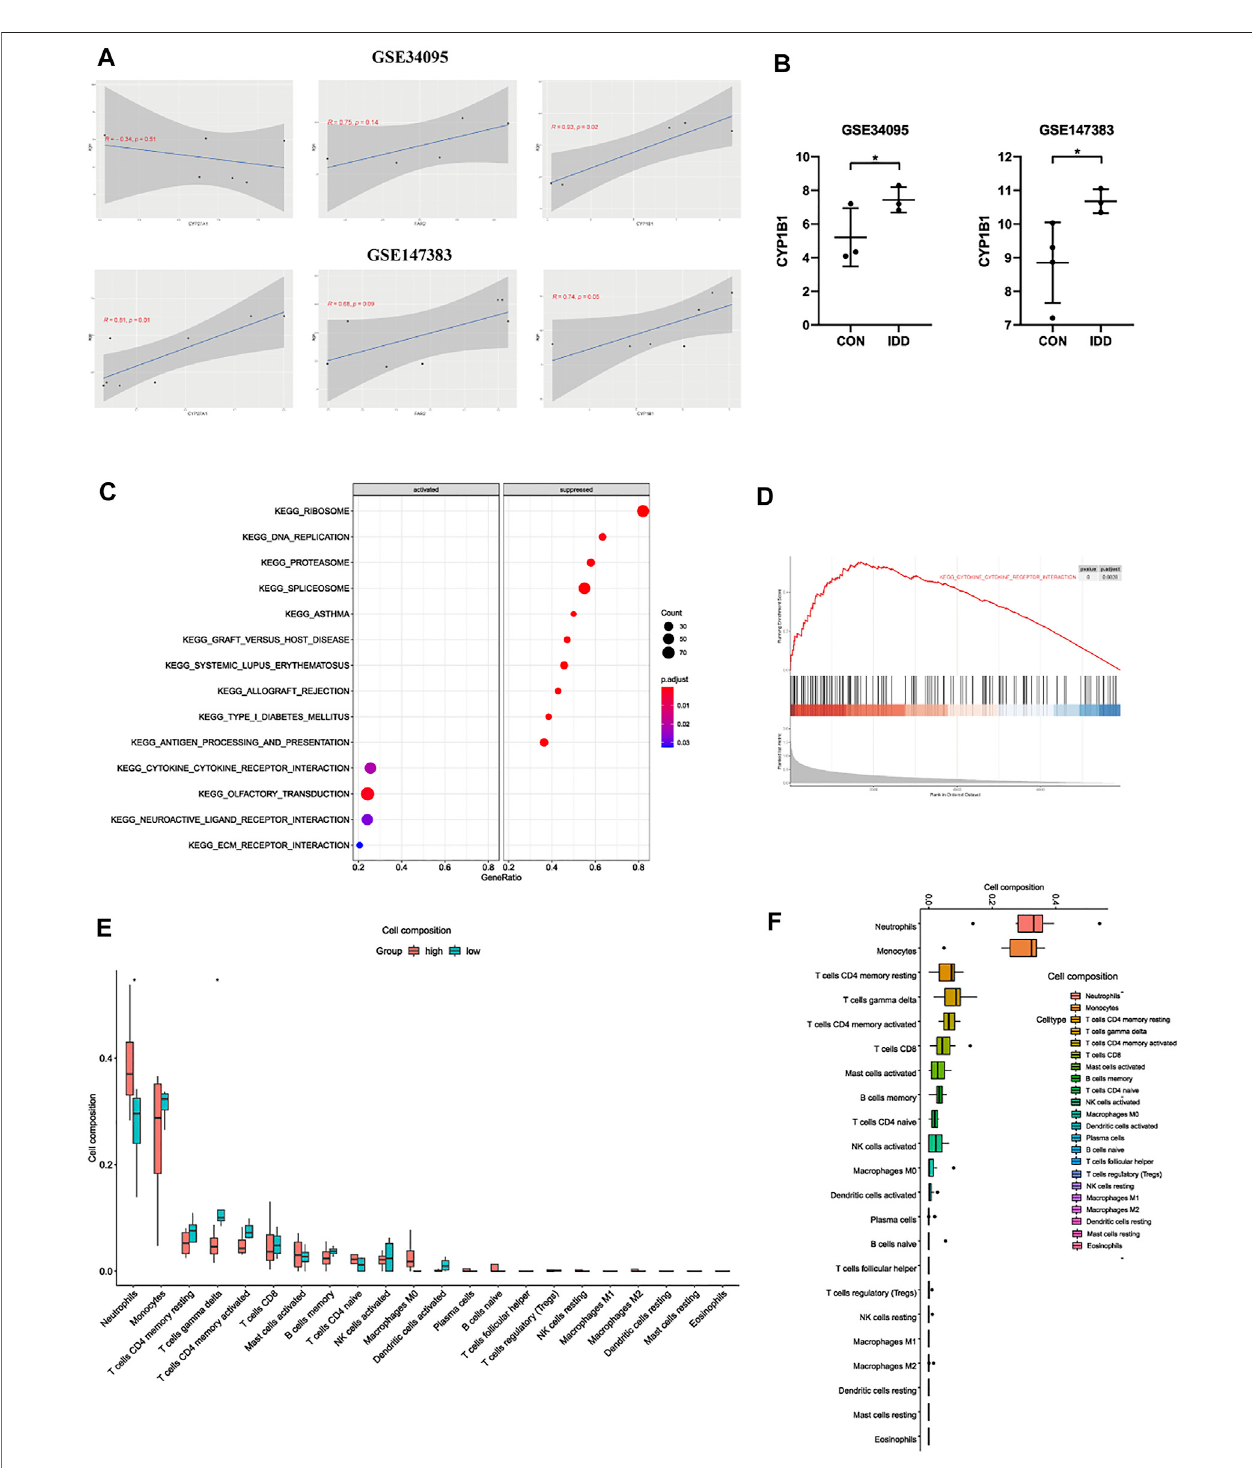
FIGURE6|(A) thecorrelationanalysisbetweenCYP27A1,FAR2,CYP1B1andclinicaltraitageinGSE34095andGSE147383. (B) furtherexpressionvalidationof CYP1B1 in other datasets. (C) bubble plot and (D) line graph of GSEA analysis based on the expression of CYP1B1 in IDD patients. (E) the relationship of immune in fi ltration levels between CYP1B1-high and CYP1B1-low group in IDD patients. (F) boxplot displaying the whole composition of immune cells in IDD patients.